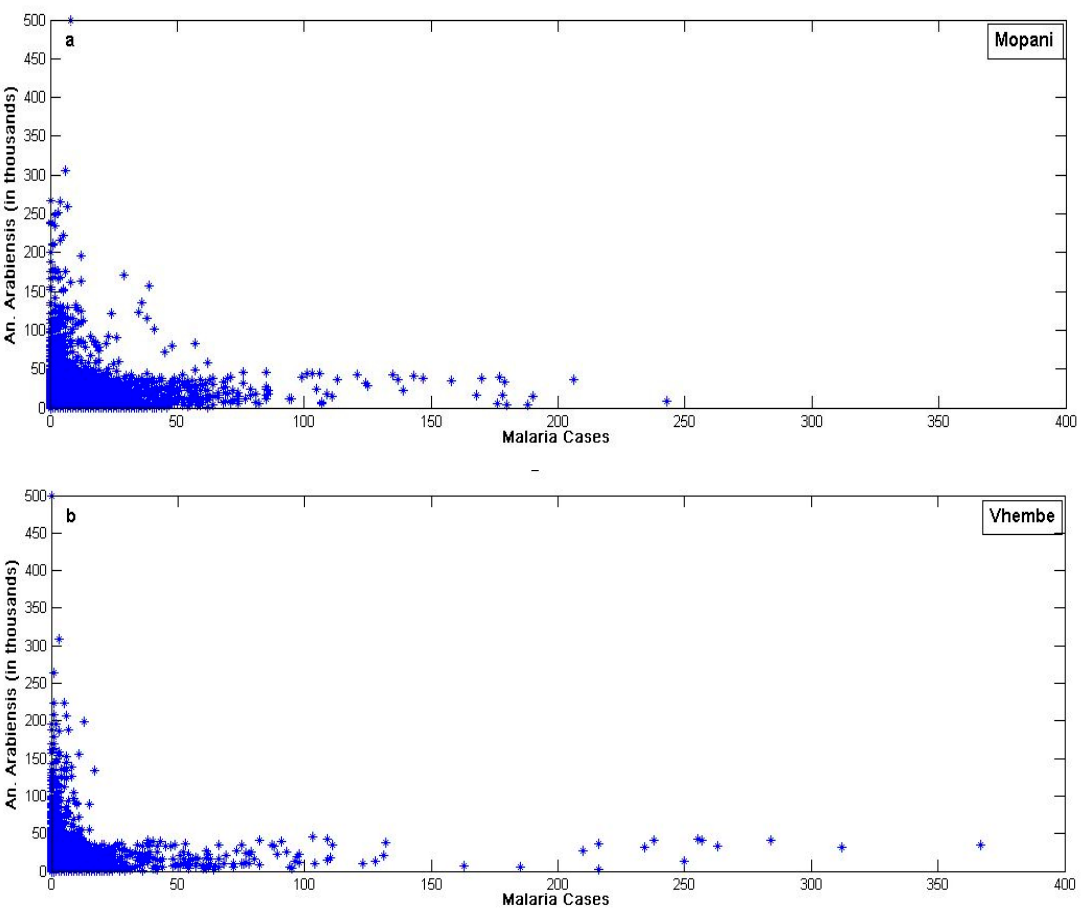
Figure 9. Scatter plot of daily simulated An. arabiensis and malaria cases over ( a ) Mopani and ( b ) Vhembe municipality, Limpopo province, South Africa from January 1998 to December 2017.